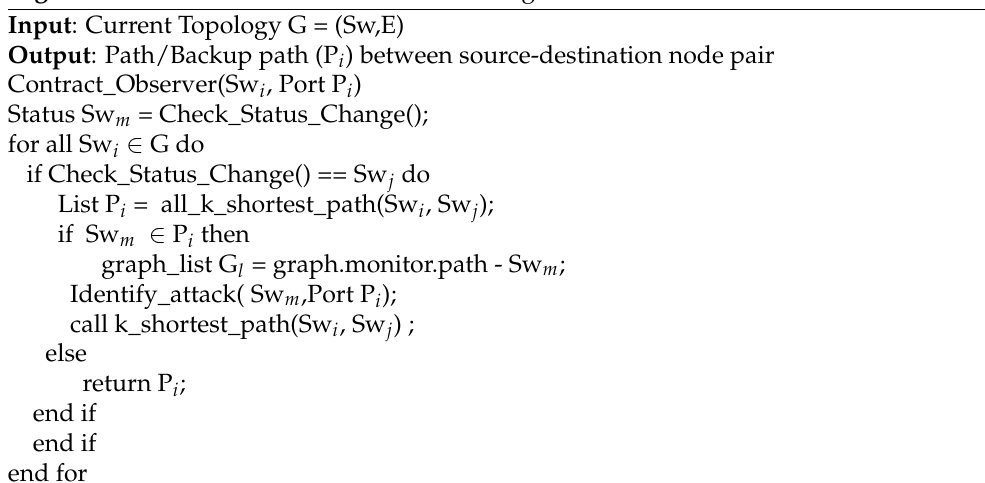
Algorithm 1 DA-DIS detection and isolation